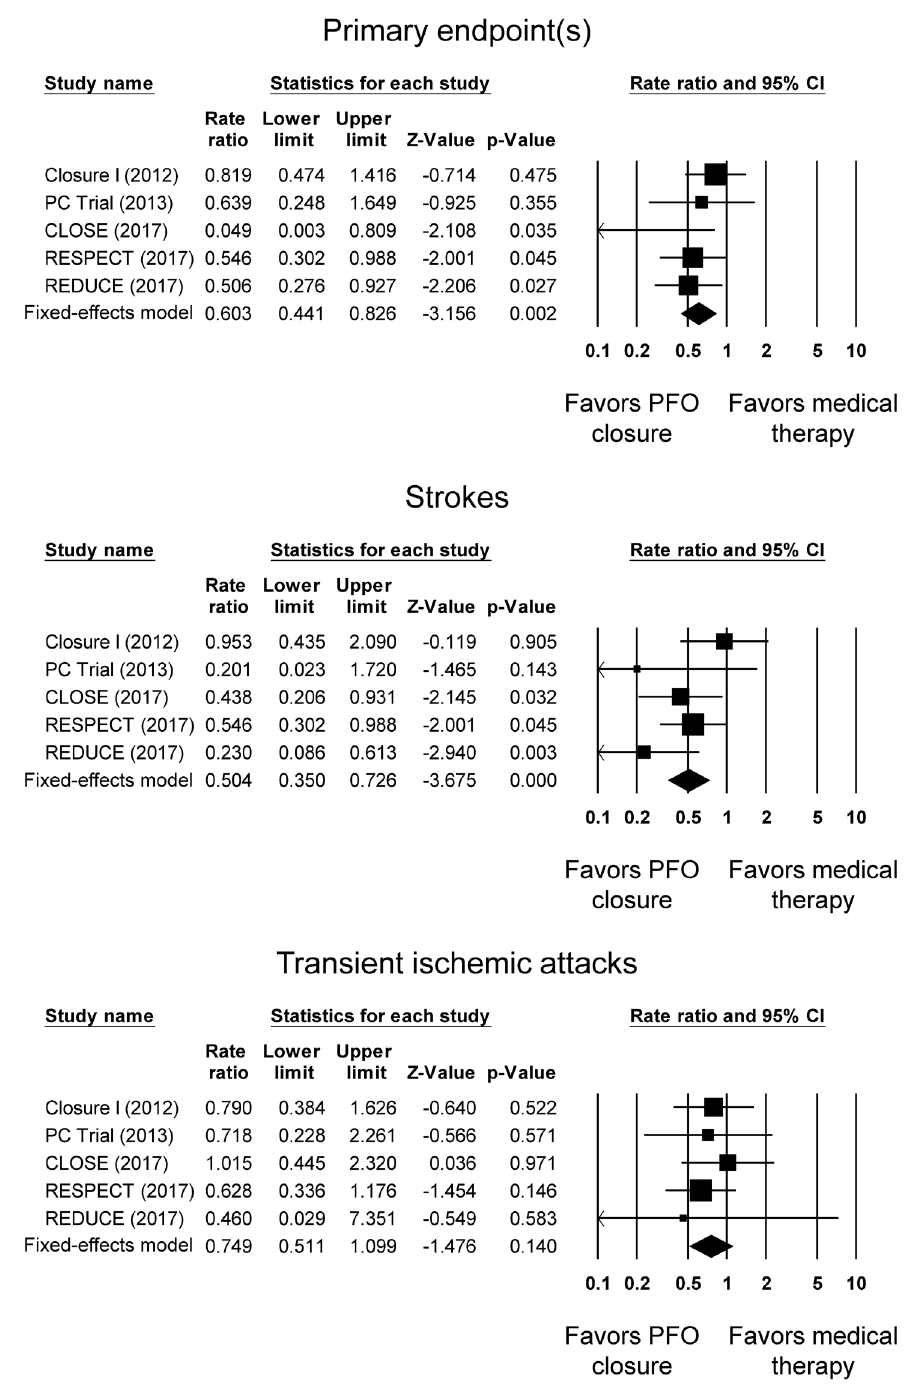
Figure 2. Rate ratios for primary endpoint(s) (top), strokes (middle) and transient ischemic attacks (TIAs; bottom) in patent foramen ovale (PFO) closure versus medical therapy. symptoms, or if imaging cannot be performed for confirma- tion, it was defined as a persistent focal neurological deficit lasting longer than 24 hours; 2) PC trial: any neurologic defi- cit lasting for >24 hours typically with documentation in MRI or computer tomography (CT); 3) CLOSE trial: sudden onset of